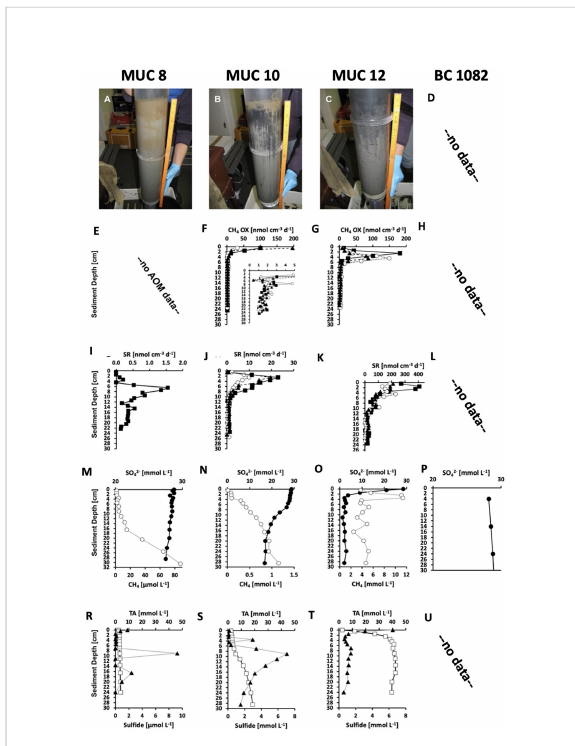
FIGURE 2 (A, B, C) Selected sediment core photos and biogeochemical parameters of MUC 8 (Stage 4, left panels, note the visible tubes at the surface), MUC 10 (Stage 4, middle panels, note the visible tubes at the surface), and MUC 12 (Stage 2, right panels, note the foamy sediment consistency caused by degassing). Note the different units for methane and sul fi de in MUC 8. Data from MUC 10 and 12 were previously published in Melaniuk et al. (2022). P) Concentration of sulfate in sediment from BC 1082. Data courtesy T. Laier, Geological Survey of Denmark and Greenland (GEUS), Copenhagen, Denmark. (E, F, G) Methane oxidation rates (CH 4 OX, symbols represent three replicates). (I, J, K, L) Sulfate reduction rates (SR, symbols represent three replicates). (M, N, O, P) Concentrations of pore-water sulfate (SO 42 − , solid circles) and sediment methane (CH 4 , open circles). Note the different x-axes for methane. (R, S, T, U) Concentrations of pore-water total alkalinity (TA, open squares), and sul fi de (solid